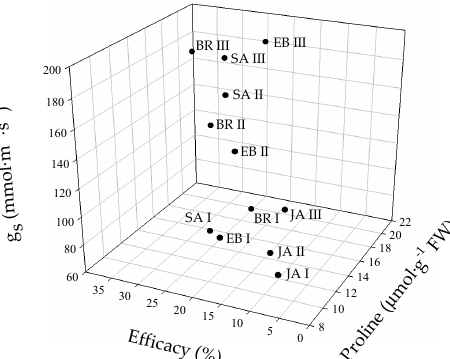
Figure 11. Three-dimensional plot (percentage efficacy, proline, and g s ) for cape gooseberry plants inoculated with Fusarium oxysporum f. sp. physali (Foph + ) and foliar applications with synthetic elicitors of resistance (brassinosteroids (BR), salicylic acid (SA), jasmonic acid (JA) or botanical extracts (BE)) at 50 days after inoculation (DAI). The data represent the mean of five data points. Abbreviations: BRI, Foph-inoculated plants with one foliar BR application; BRII, Foph-inoculated plants with two foliar BR applications; BRIII, Foph-inoculated plants with three foliar BR applications; SAI, Foph-inoculated plants with one foliar SA application; SAII, Foph-inoculated plants with two foliar SA applications; SAIII, Foph-inoculated plants with three foliar SA applications; JAI, Foph-inoculated plants with one foliar JA application; JAII, Foph-inoculated plants with two foliar JA applications; JAIII, Foph-inoculated plants with three foliar JA applications; BEI, Foph-inoculated plants with one foliar BE application; BEII, Foph-inoculated plants with two foliar BE applications; BEIII, Foph-inoculated plants with three foliar BE applications.